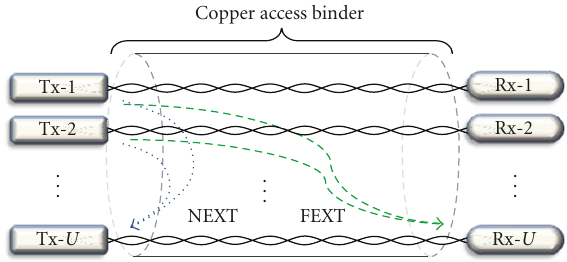
Figure 2: Sequential SIMO transmission with only one active transmitter (Tx) per estimation sequence m = 1,2, ... , U . The far- end receivers (Rx) measure the FEXT for each sequence, whereupon the MIMO FEXT channel matrix can be estimated. The MIMO NEXT channel matrix can be estimated in the same way by using Rx:s located at the same side of the binder as